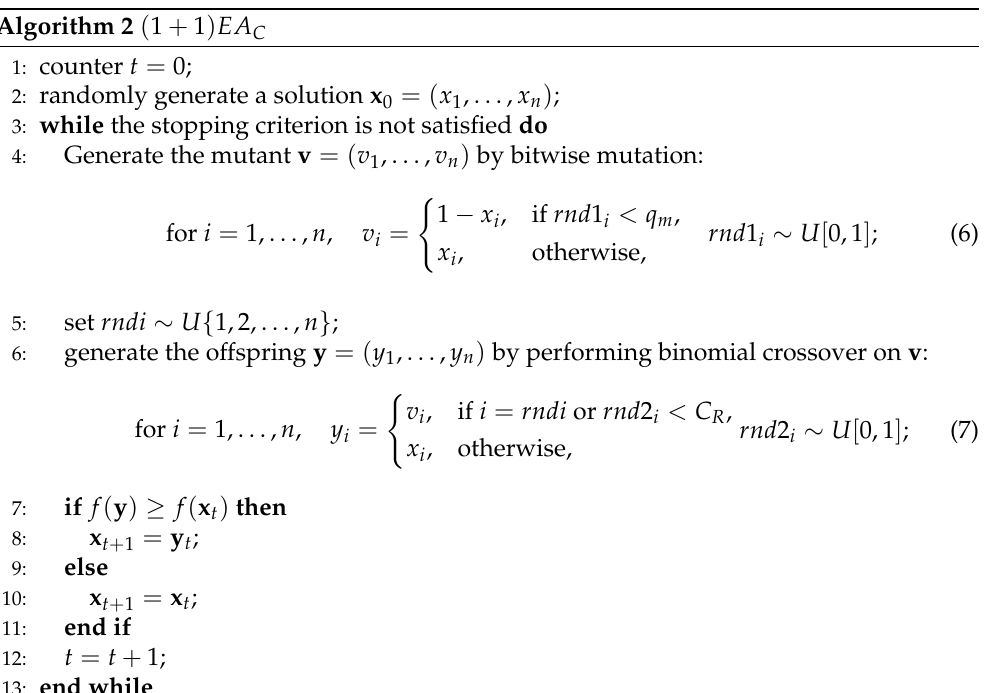
Algorithm 2 ( 1 + 1 ) EA